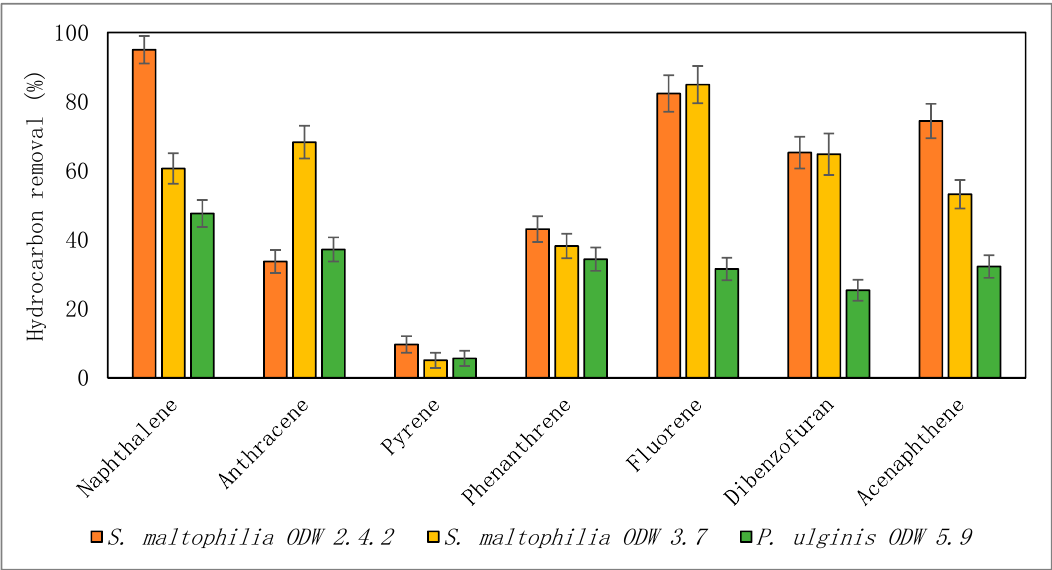
Figure 1. Removal of selected PAH present in creosote by selected strains after 28 days.